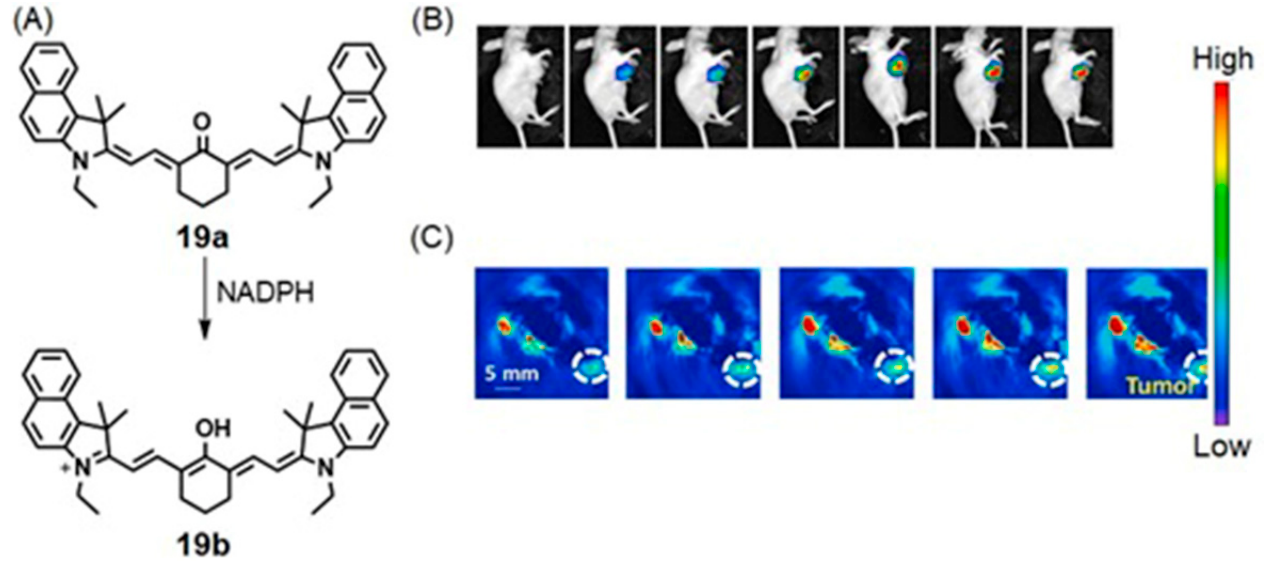
Figure 42. In vivo imaging studies of 19 . ( A ) Chemical structures and conversion of 19a into 19b in the presence of NADPH. ( B ) Time-dependent near-IR fluorescence images of tumor-bearing mice injected with 19a [images were collected at (left to right) 0, 5, 30, 60, 90, 120, and 150 min]. ( C ) Time- dependent photoacoustic images of tumor-bearing mice injected with 19a [images were collected at (left to right) 0, 30, 60, 90, and 120 min]. The tumor site is indicated by white dashed circles. Relative fluorescence intensity and photoacoustic intensity of images increase with time due to the formation of 19b . Adapted from Biomaterials , 271 , Tian, Y.; Jiang, W.-L.; Wang, W.-X.; Mao, G.-J.; Li, Y.; Li, C.-Y. NAD(P)H-triggered probe for dual-modal imaging during energy metabolism and novel strategy of enhanced photothermal therapy in tumor, 120736, Copyright 2021, with permission from Elsevier [349].